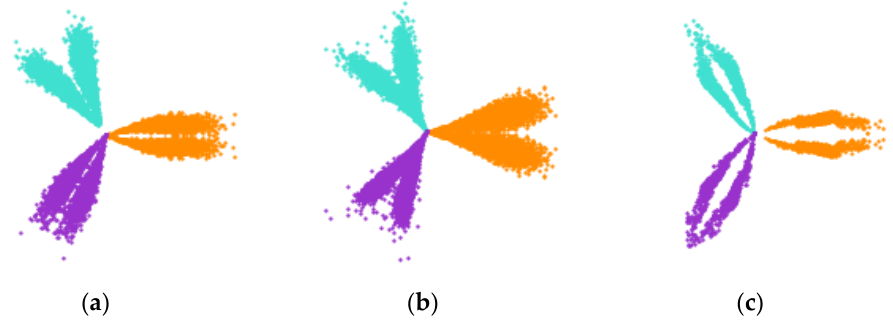
Figure 17. Clustering templates of sensor 2 in the three pitting level. ( a ) Normal; ( b ) Single pitting; ( c ) Double pitting.